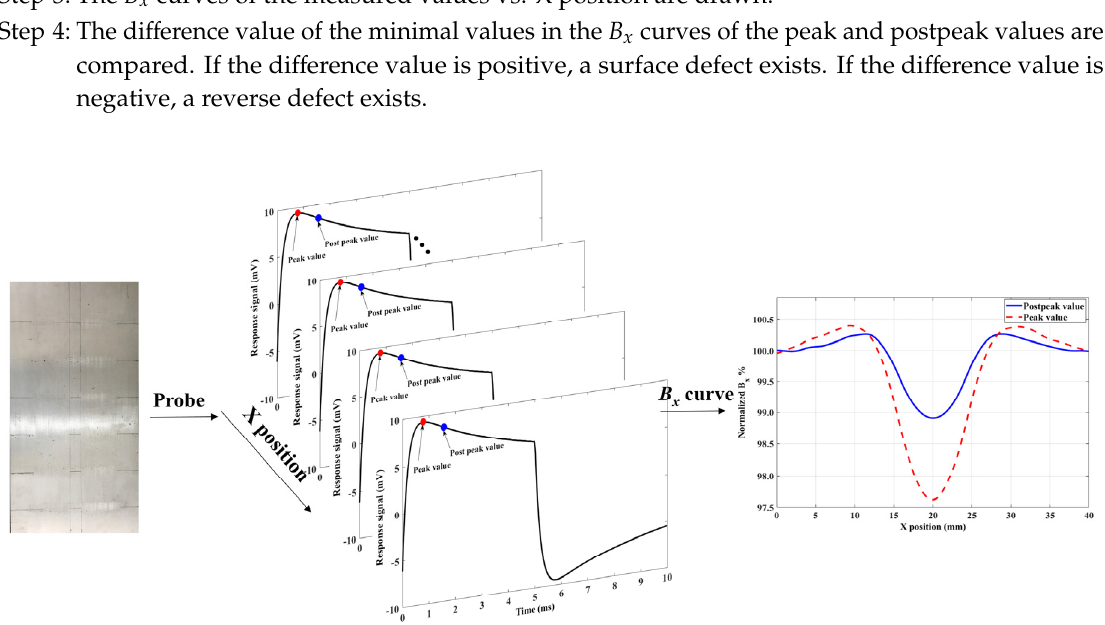
Figure 8. Classification method procedure.